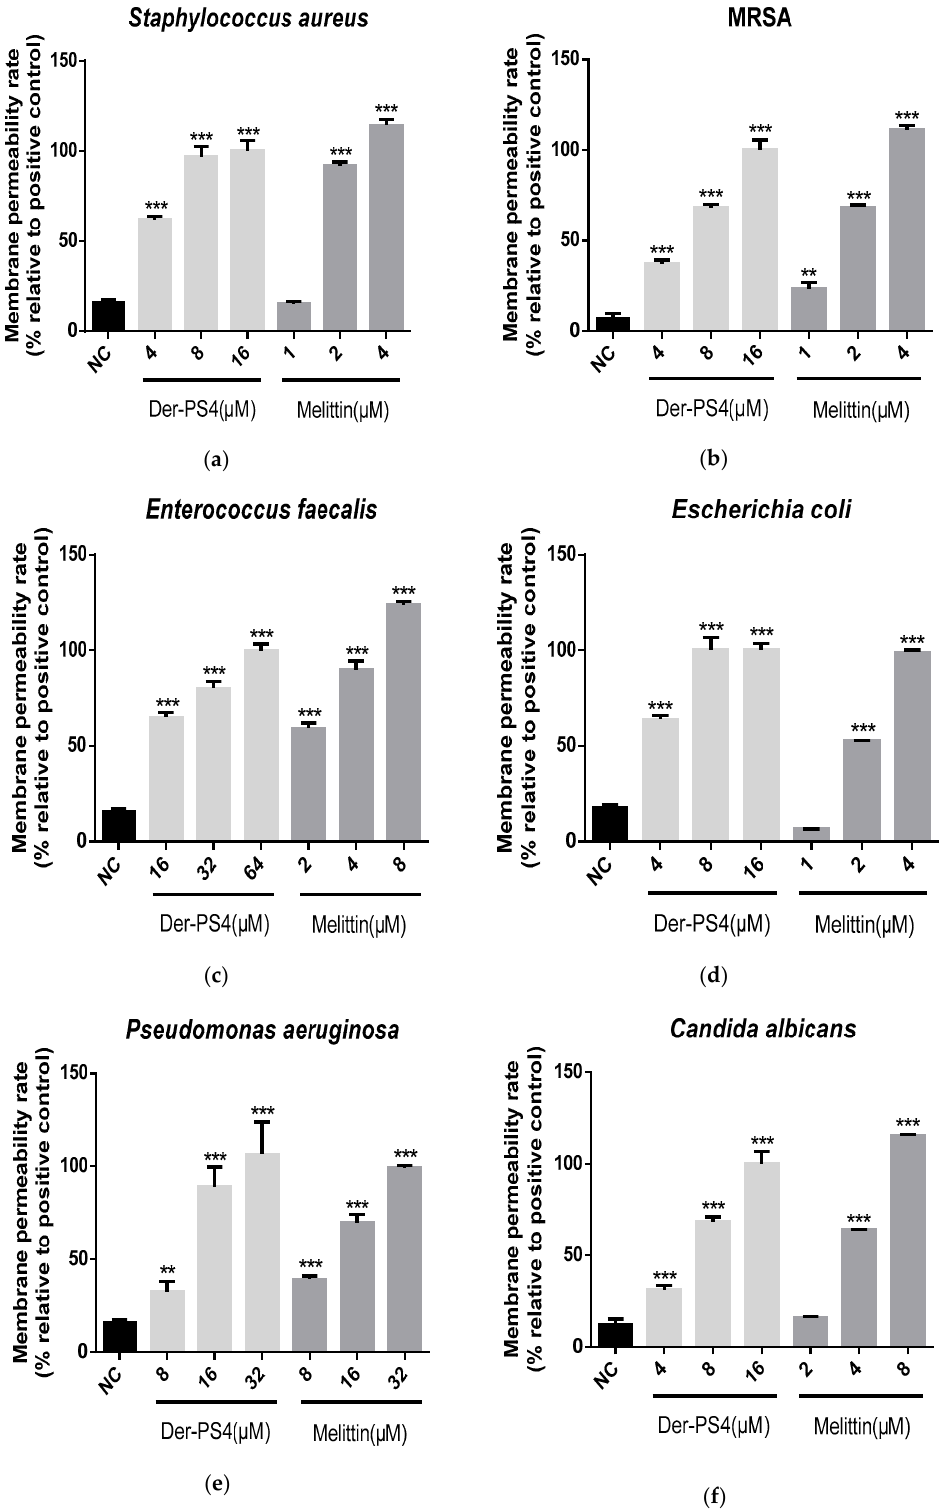
Figure 7. The permeabilization activities of Der-PS4 were evaluated on S. aureus ( a ), MRSA ( b ), E. faecalis ( c ), E. coli ( d ), P. aeruginosa ( e ) and C. albicans ( f ). Negative control (NC) was acquired after incubation with 5% tryptic soy broth (TSB) in 0.85% NaCl. Positive control was acquired after incubation with 70% isopropanol. Data represent means ± SEM (standard error of the mean) of five replicates. The levels of significance are: ** p < 0.01, *** p < 0.001.